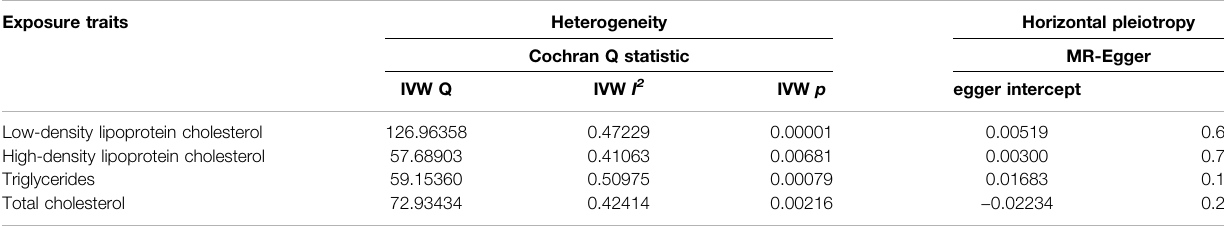
TABLE 1 | Heterogeneity and horizontal pleiotropy analyses between SLE and blood lipids. Exposure